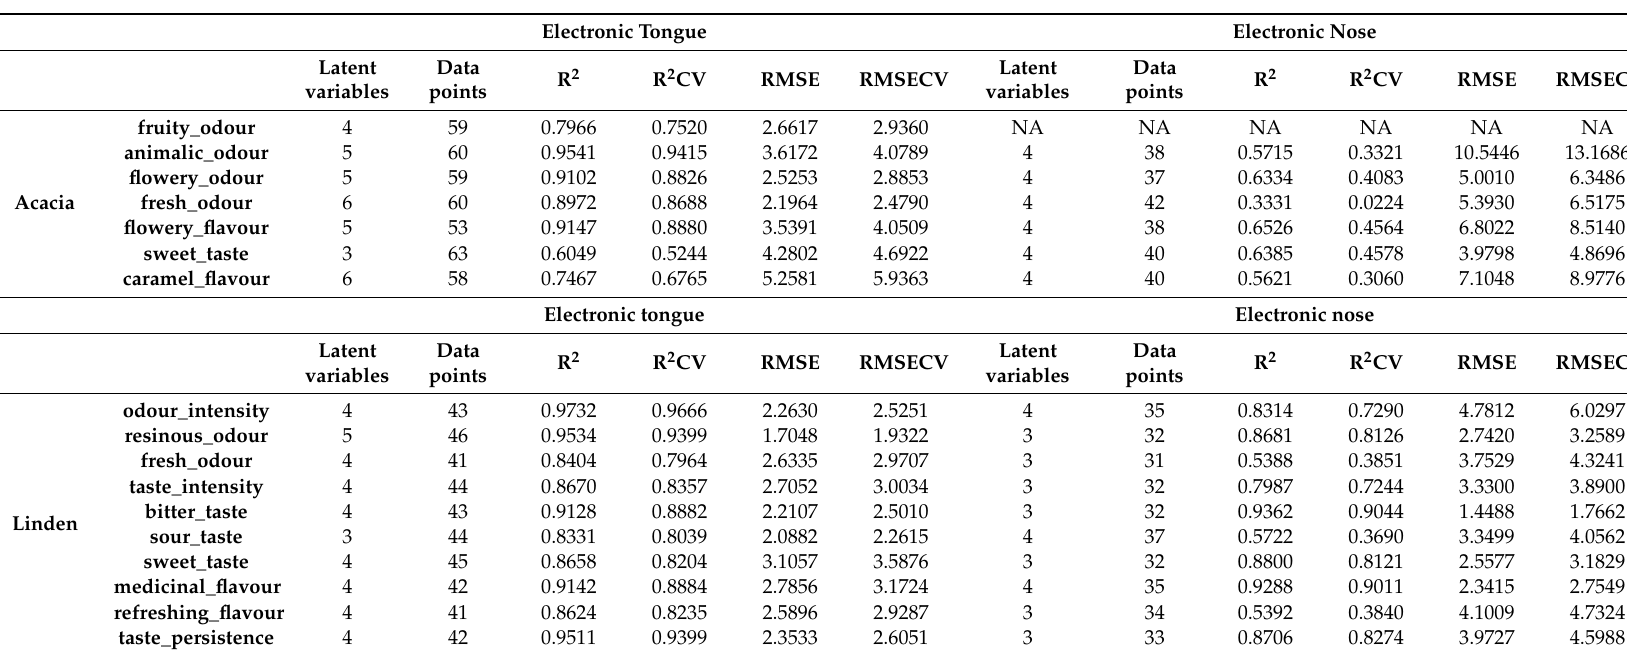
Table 6. Results of the regression models built on the properties of sensory profile analyses of acacia and linden honey used in sensory profile analyses based on data of the electronic tongue and